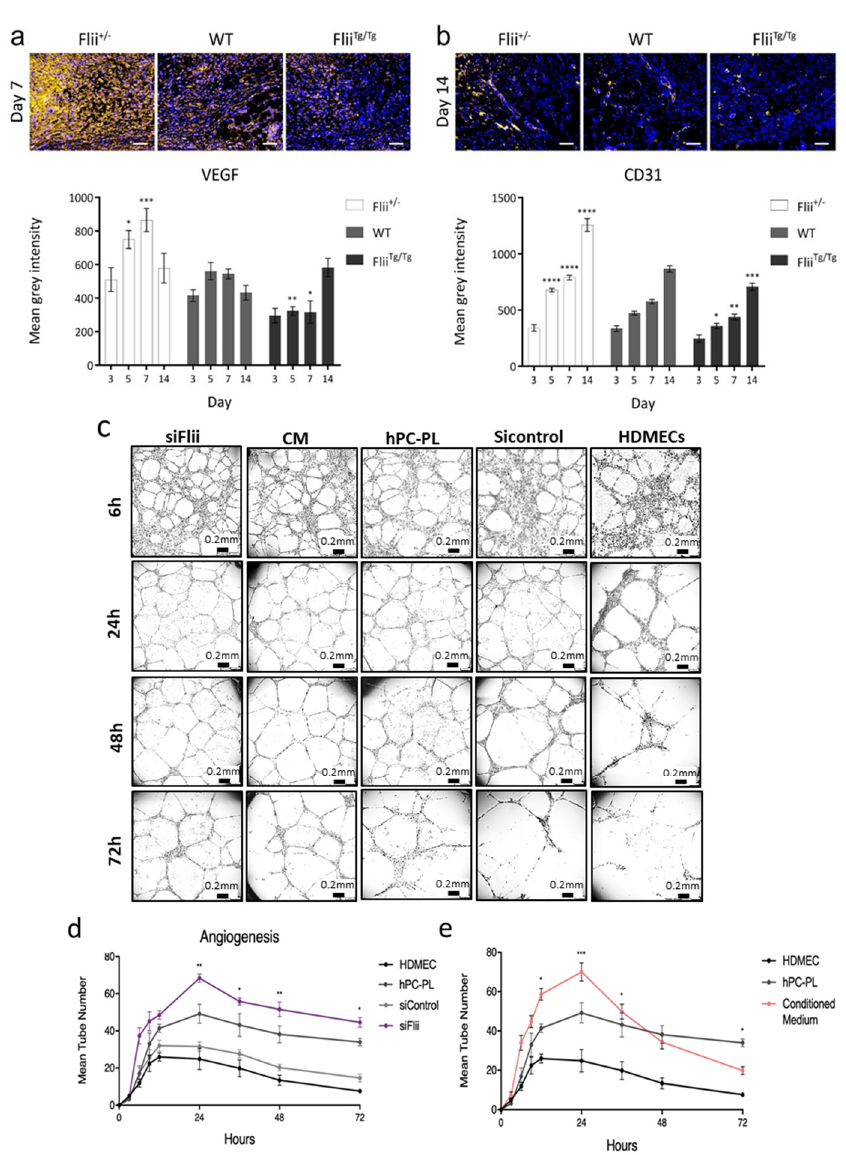
Figure 5. ( a ) Immunohistochemical detection and quantification of vascular endothelial growth factor (VEGF) in 4 µ m sections of para ffi n-embedded diabetic Flii +/ − , WT and Flii Tg / Tg wounds. Images taken at 20 × objective, scale bar = 50 µ m. Data displayed as mean ± SEM, n = 7. ( b ) Immunohistochemical detection and quantification of CD31 in 4 µ m sections of para ffi n-embedded diabetic Flii +/ − , WT and Flii Tg / Tg wounds. Images taken at 20 × objective, scale bar = 50 µ m. Data displayed as mean ± SEM, n = 7. ( c ) Representative images of tube formation in HDMECs alone and HDMECs co-cultured with hPC-PLs, siControl hPC-PLs, siFlii hPC-PLs and hPC-PL CM at 6, 24, 48 and 72 h. Images taken at 4 × objective, scale bar = 200 µ m. ( d ) E ff ect of untreated, siControl-treated or siFlii-treated hPC-PLs on human dermal microvascular endothelial cells (HDMECs) and ( e ) E ff ect of hPC-PL CM or hPC-PL co-culture on HDMEC sprouting in a matrigel tube formation assay. All data displayed as mean ± SEM, n = 5. Results representative of three independently conducted experiments. Statistical significance calculated by two-way ANOVA, where * = p < 0.05, ** = p < 0.01, *** = p < 0.001, **** = p <